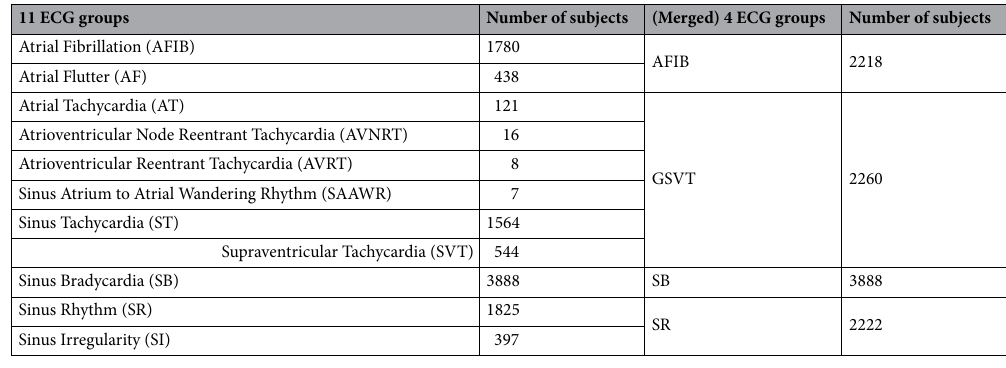
Table 1. Information on the 11 ECG rhythms and the 4 merged ECG groups.